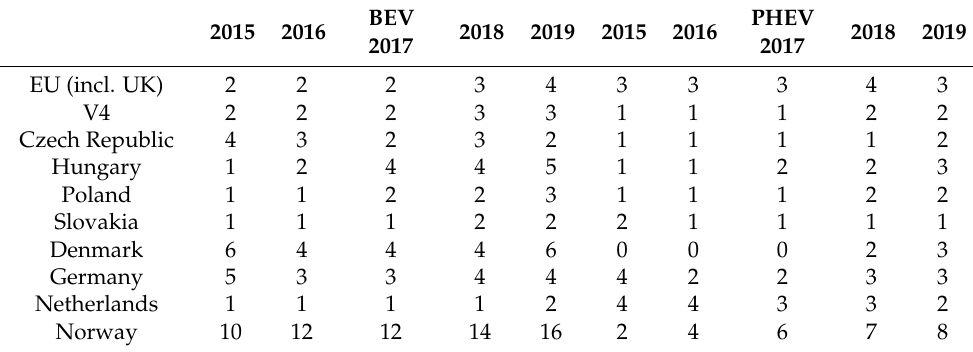
Table 5. The number of BEVs and PHEVs per public charging point, (source: elaborated by authors based on